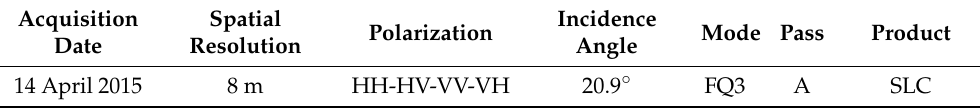
Table 1. Detailed information of the RADARSAT-2 satellite image used in the study.